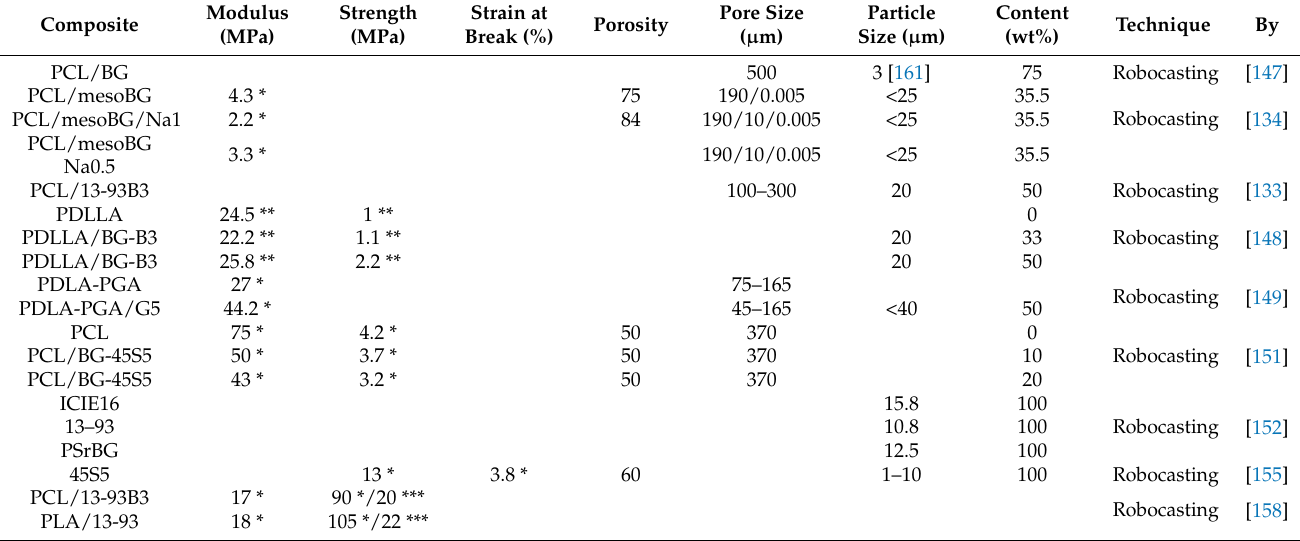
Table 5. Principal properties of Robocasting investigations. With * the compression, ** tensile and *** flexural modulus/strength (not filled cells mean no